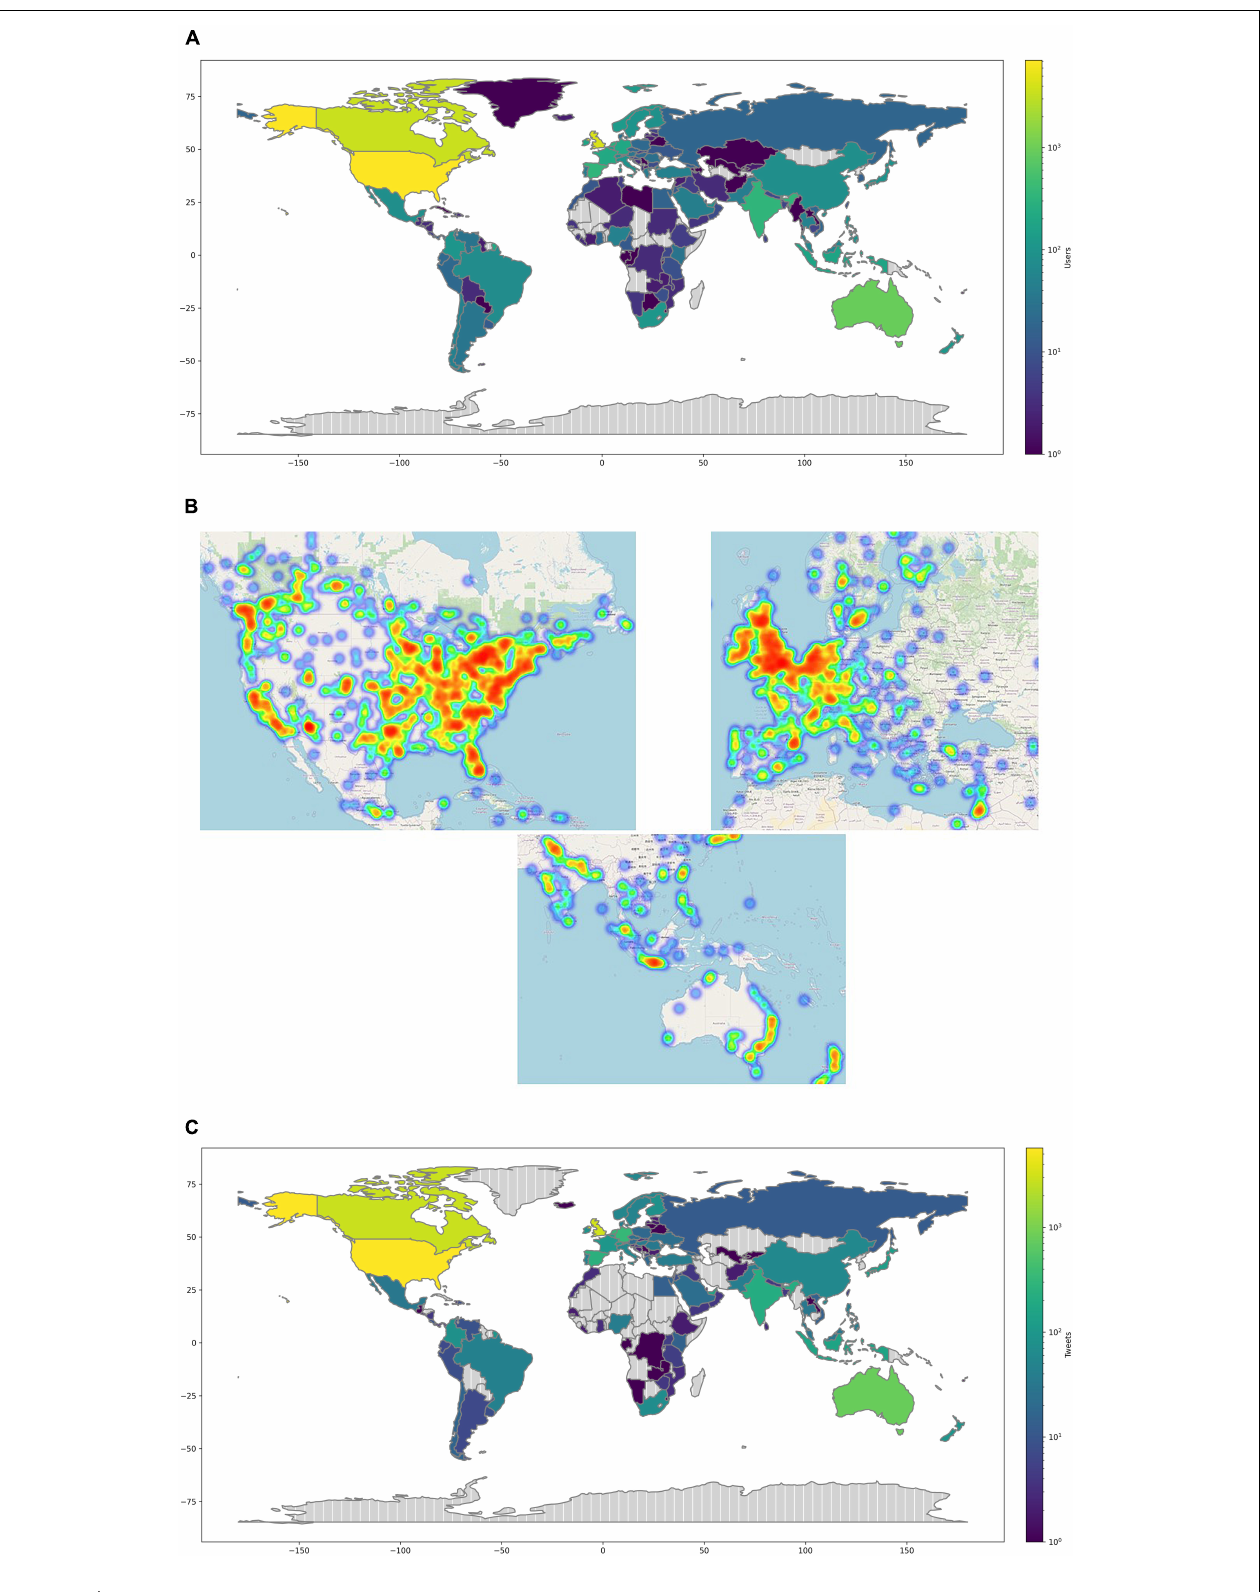
FIGURE 4 | SRL geocoding stats. (A) Top, log scaled normalization of Twitter geotagged user. (B) Middle, from left to right, geotagged users heatmap of North America, Europe and the Middle East, and eastern Australasia. (C) Bottom, log scaled normalization of tweets per country.